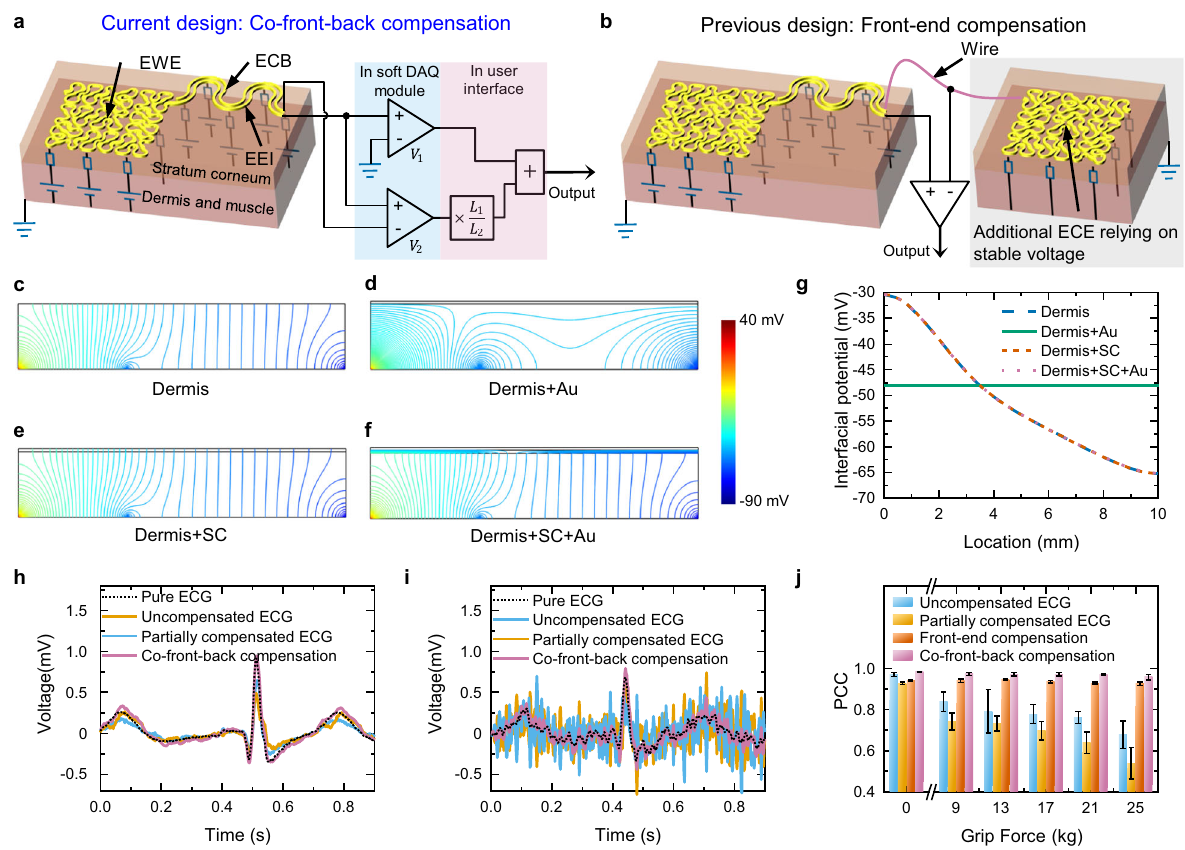
Fig. 2 Signal compensation model and experimental validation. a Schematic of co-front-back compensation. b Schematic of front-end compensation proposed in the previous work. c The potential distribution in dermis without stratum corneum. d The potential distribution in dermis covered with a layer of gold (Au). e The potential distribution in dermis covered with stratum corneum. f The potential distribution in dermis covered with two layers of SC and Au. g Interfacial potential of dermis extracted from c – f . h ECG measured with forearm relaxed. i ECG measured with forearm gripping. j Pearson correlation coef fi cient (PCC) with respect to grip force. Error bars represent the standard deviation of 3